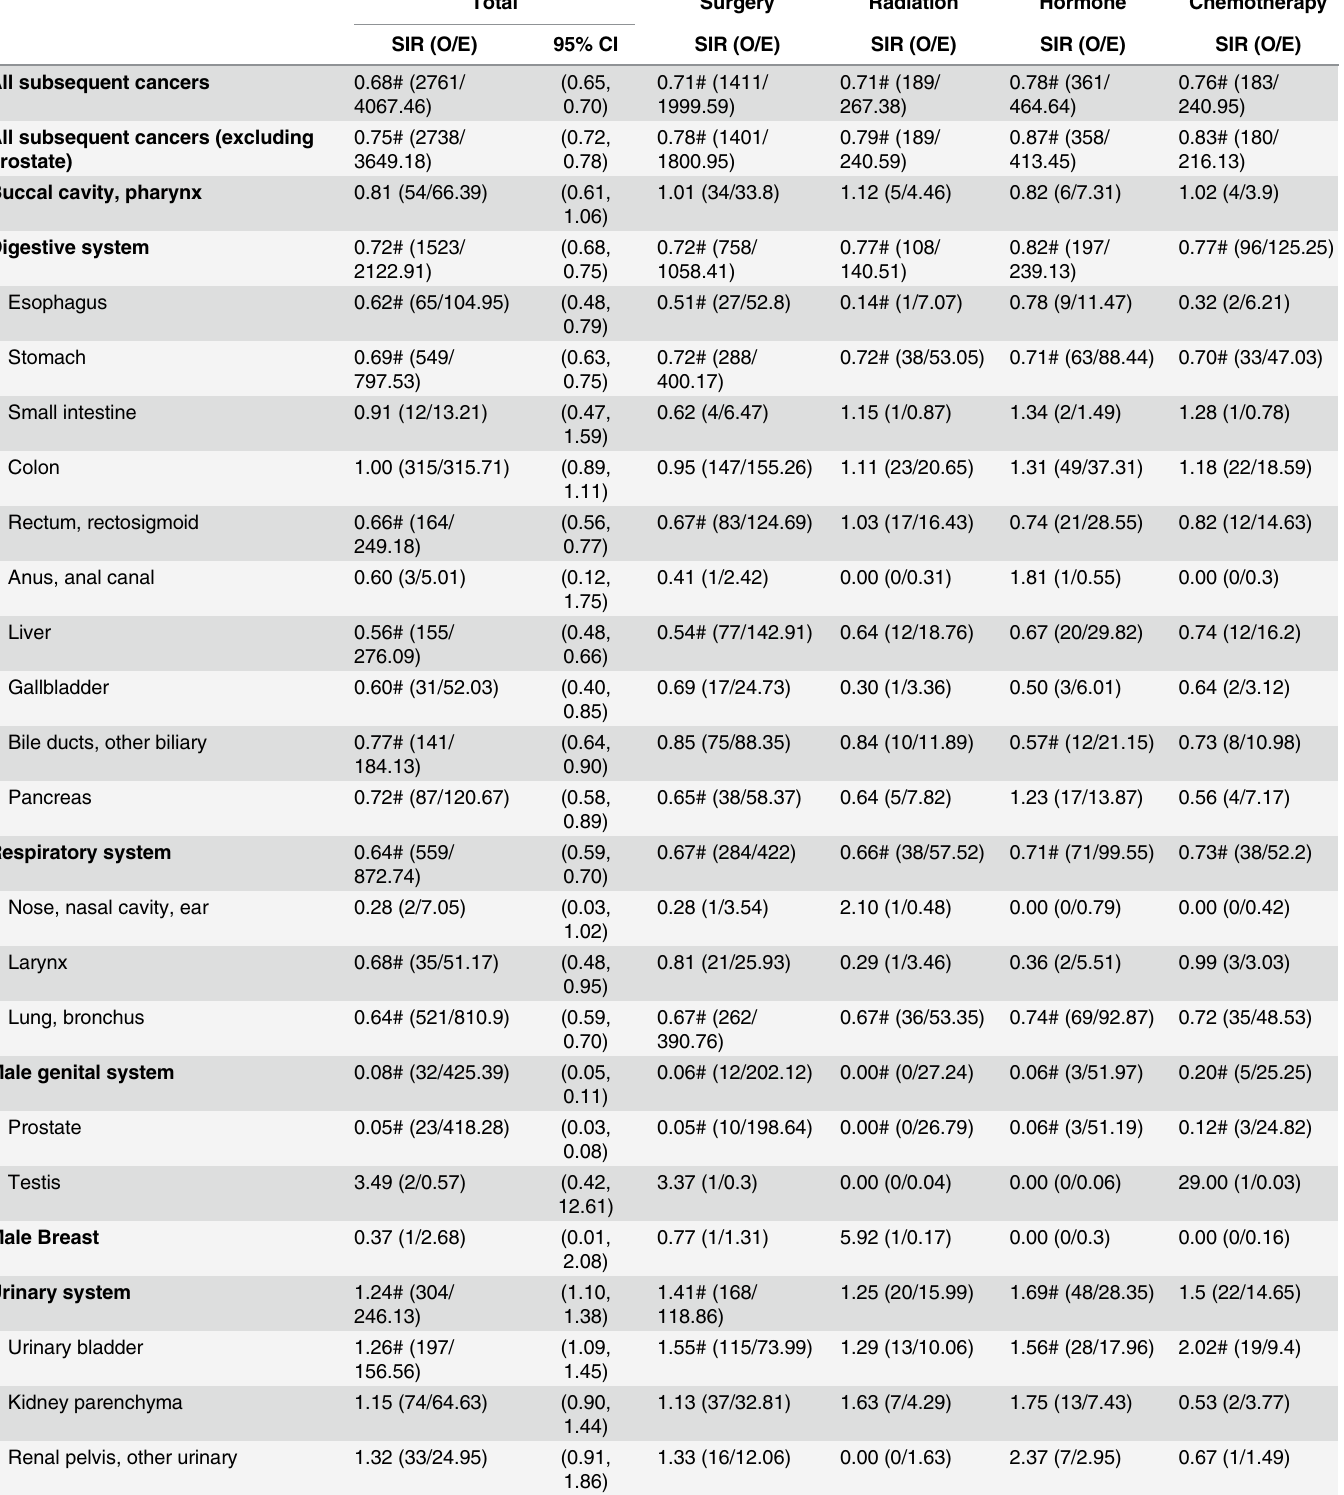
Table 3. Risk of subsequent primary cancers by primary treatment a for prostate cancers diagnosed between 1993 and 2011. Total Surgery